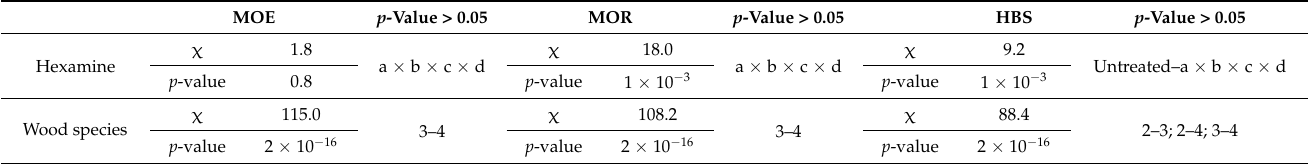
Table 3. Kruskal and post hoc Dunn tests for MOE, MOR and HB as a function of wood species and amount of